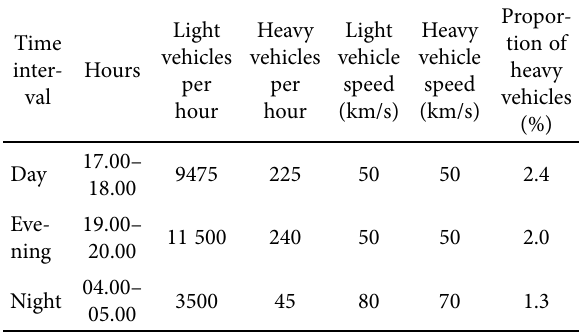
Table 1. Traffic data for the Bosporus